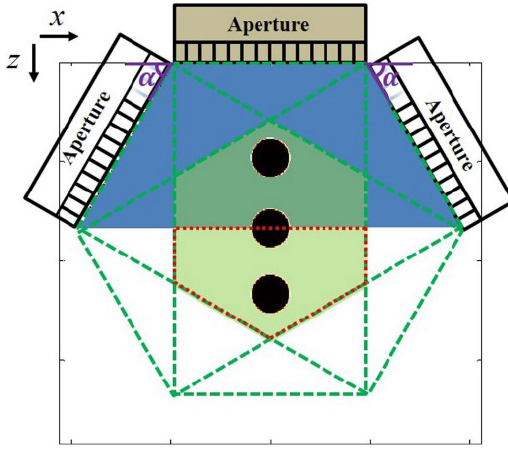
Fig. 1. Schematic of aperture orientation e®ect in the synthetic aperture